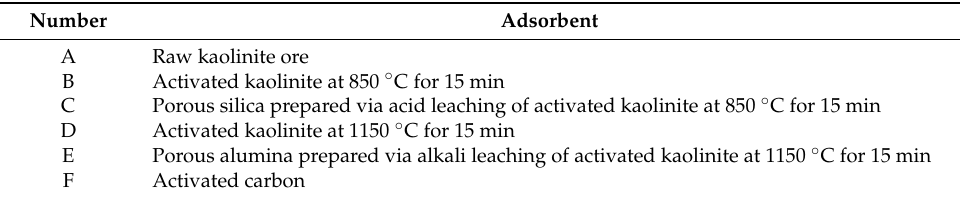
Table 4. Various adsorbents used in the comparative adsorption experiments.